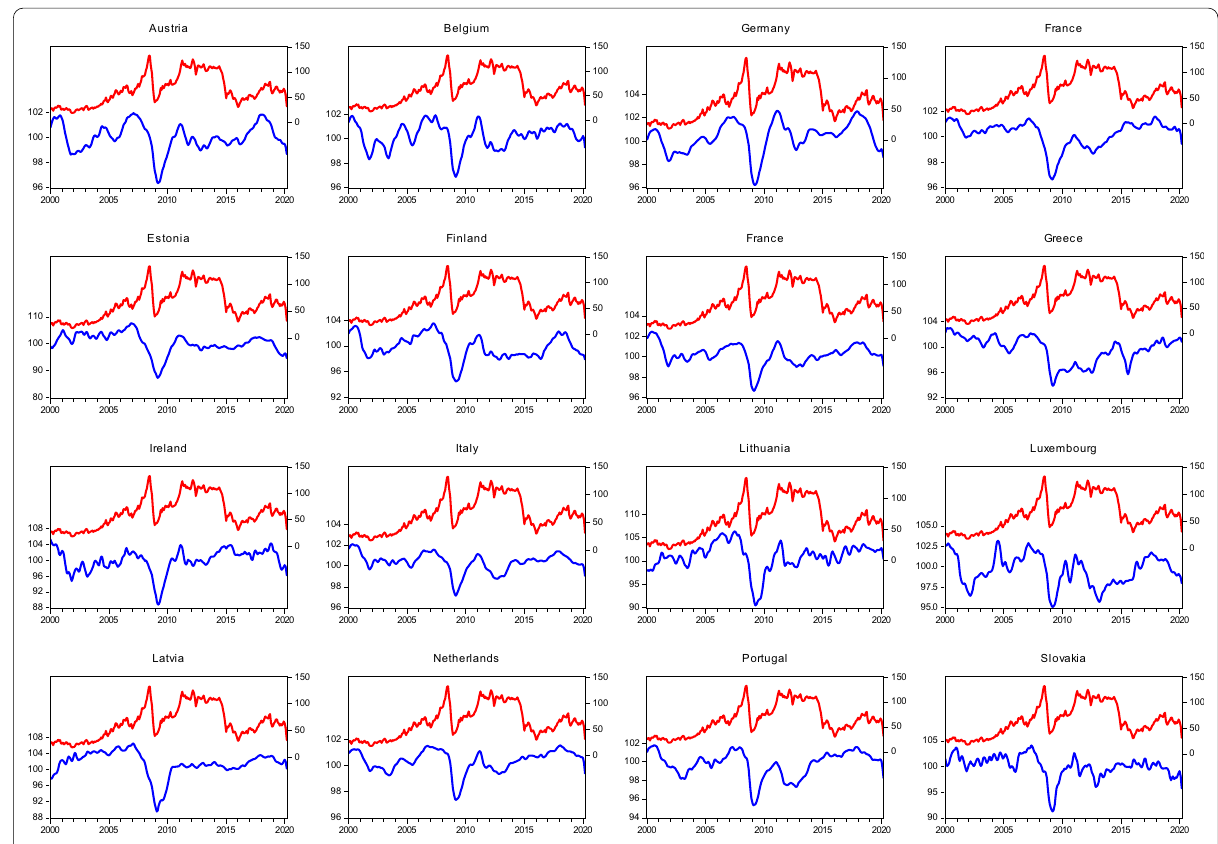
Fig. 1 Trends in business confidence and global oil price in the Eurozone